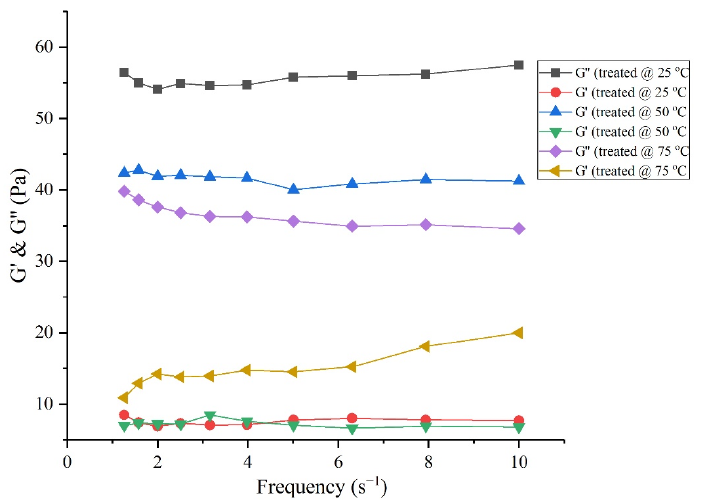
Figure 6. Elastic modulus (G ′ ) and viscus modulus (G ″ ) of the crude oil before and after aquather- molysis at different temperatures.